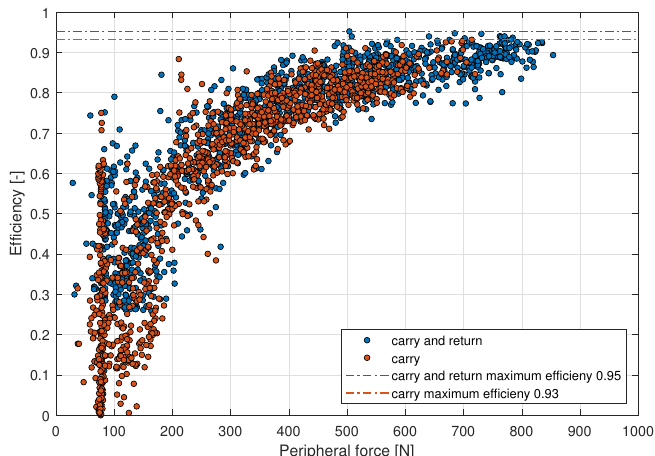
Figure 12. Mechanical efficiency as a function of intermediate drive peripheral force for two work